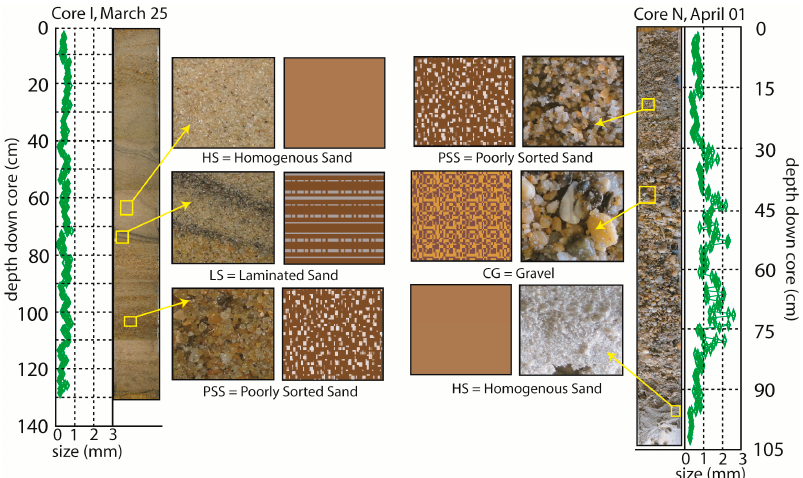
Figure 4. Two different cores are shown to illustrate the four units (represented by the different brown fill patterns) used in describing the stratigraphy. Detailed photographs show enlarged sub-sections, and the DIS profiles are shown in green. These general units are chosen owing to their prevalence as well as their dynamical